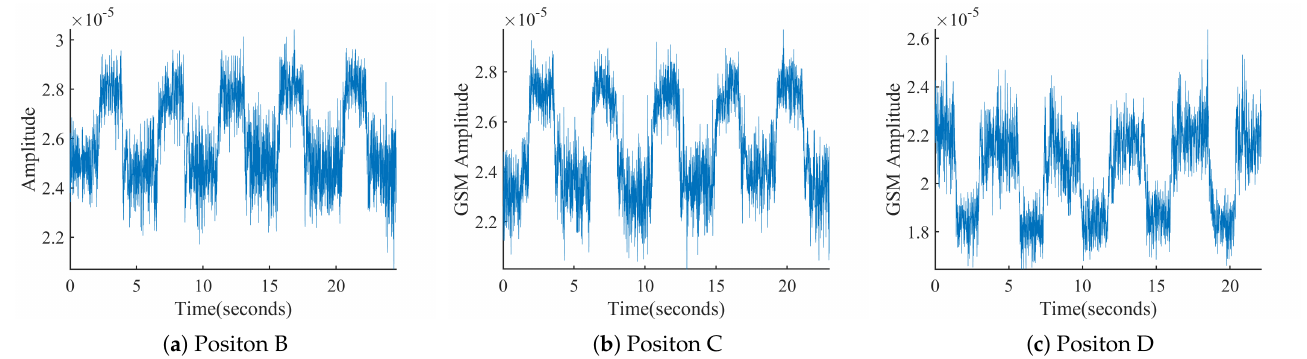
Figure 5. Down-sampled signal sequence recorded while squatting at different